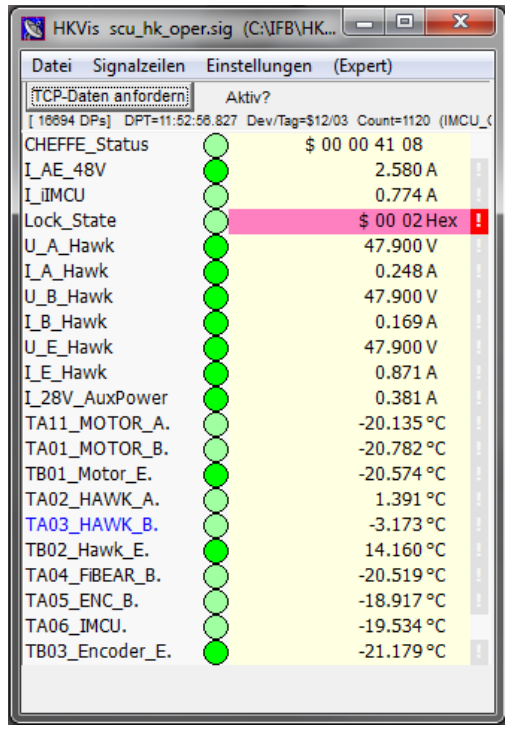
Figure 5. Typical housekeeping visualisation showing parameters transmitted via different data packets. The disposition of the values as well as the displayed information such as units or out of range indicators can be chosen as desired by the